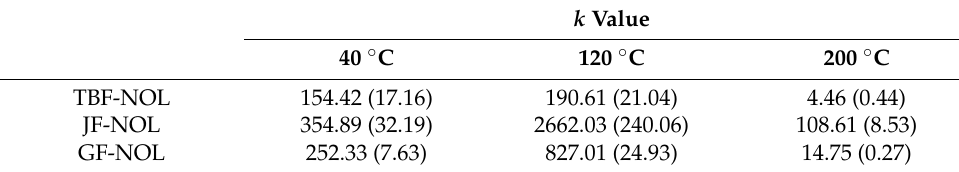
Figure 9. DMA performance data at various frequencies: ( a – c ) TBF-NOL composite; ( d – f ) JF-NOL composite; ( g – i ) GF-NOL composite. Table 2. k values of NOL rings of different composites.